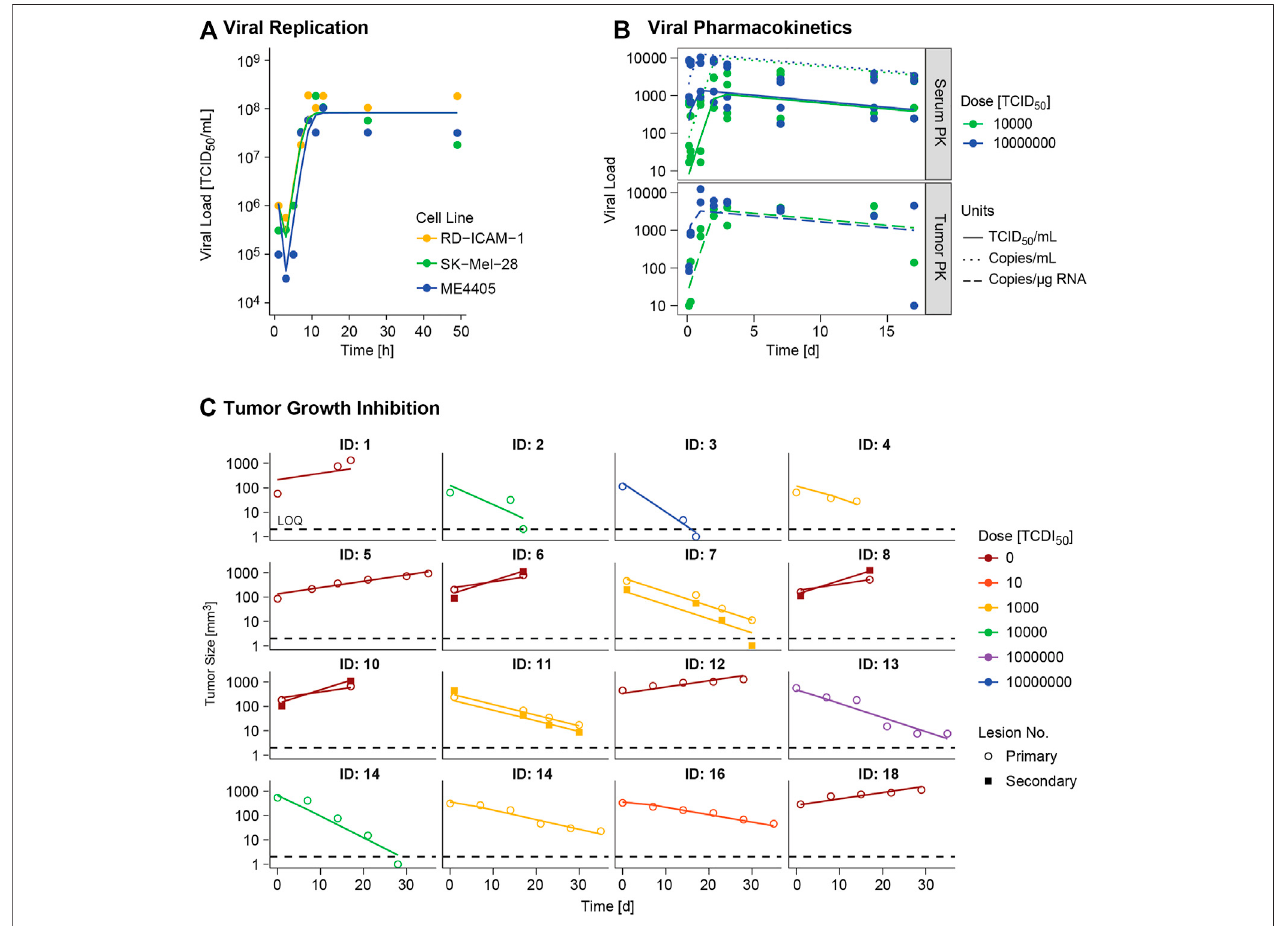
FIGURE 3 | Model evaluation. Model predictions (lines) versus real observations (dots) for (A) in vitro viral replication model and (B) in vivo viral kinetic model at typical level, and (C) tumor growth inhibition model at individual level for the different experimental scenarios. ID: individual. In panel A viral dynamics of RD-ICAM-1 and SK-Mel-28 are almost equivalent and model predictions appear